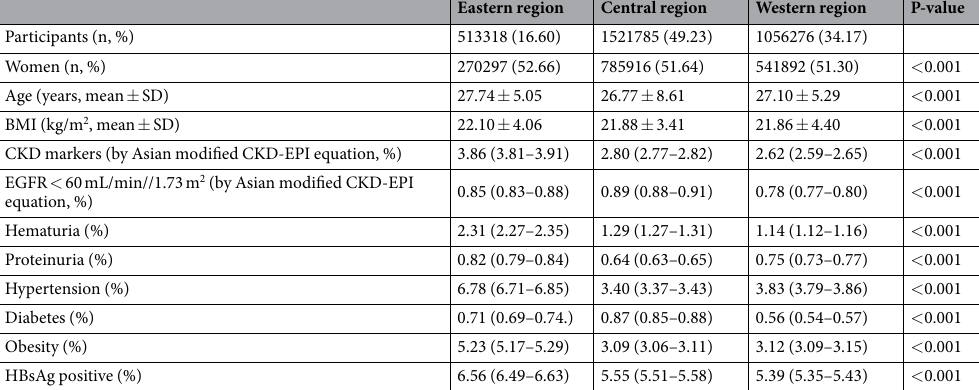
Table 3. Prevalence of and risk factors for CKD in the married population with fertility desire by regions in rural China. Data are represented as n (%), % (95% CI), or mean ± SD. BMI: body-mass index. CKD: chronic kidney disease. EGFR: estimated glomerular filtration rate. CKD-EPI equation: chronic kidney disease epidemiology collaboration equation. Obesity: BMI ≥ 28 (kg/m 2 ). HBsAg: hepatitis B virus surface antigen. SD: standard deviation. CI: confidence interval.